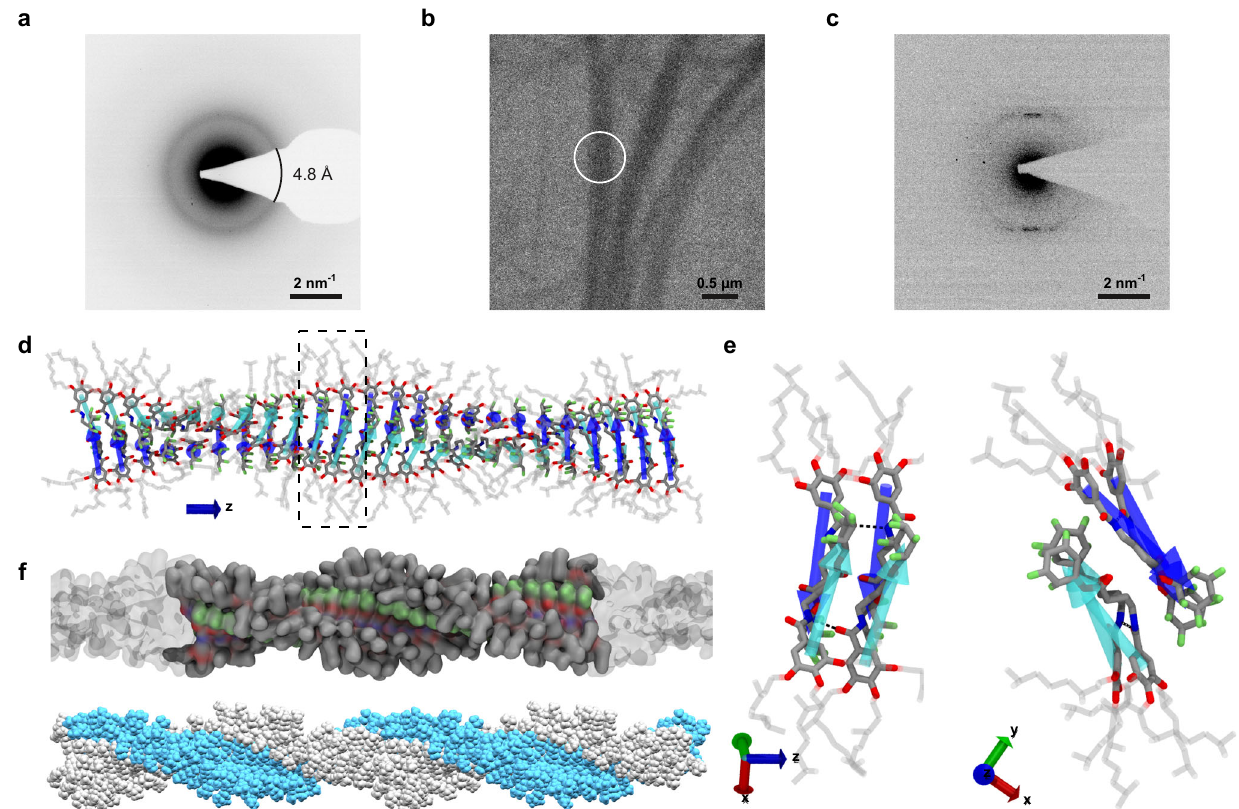
Fig. 6 Structure of the fi bers. a Electron diffraction pattern of the organic fi bers under low-dose conditions (electron dose: 0.45 e − /Å 2 ). The diameter of the illuminated area was c.a. 5 μ m. The diffraction ring is located at 2.1 nm − 1 , corresponding to a lattice spacing of 4.8 Å. b Bright- fi eld TEM image showing several bundles of the organic fi bers. The circle indicates the position of the selected-area aperture with a diameter of 0.7 μ m. c Selected-area electron diffraction pattern acquired from the circular region in ( b ) with an electron dose of 0.12 e − /Å 2 . d Atomistic detail of the monomer arrangement in the helix structure — blue and cyan arrows connecting the benzene (tail) to the penta fl uorocyclohexyl groups (head). Color code: green: F; red: O; blue: N; gray: C. e Details of the side (left) and the top (right) views of the arrangement of four M 3 in the helix (monomers within the black rectangle in d ). H-bonds between the monomers are shown as dashed black lines. f Top: equilibrated snapshot of a M 3 pre-assembled fi ber after 1 μ s of MD simulation. The system corresponds to a full helical turn with a pitch of ~12 nm (opaque), forming an in fi nite helicoidal fi ber through the periodic boundaries (periodic images shown in transparency). Bottom: space- fi lling model of M 3 polymer demonstrating relative arrangement of two monomer stacks (gray and